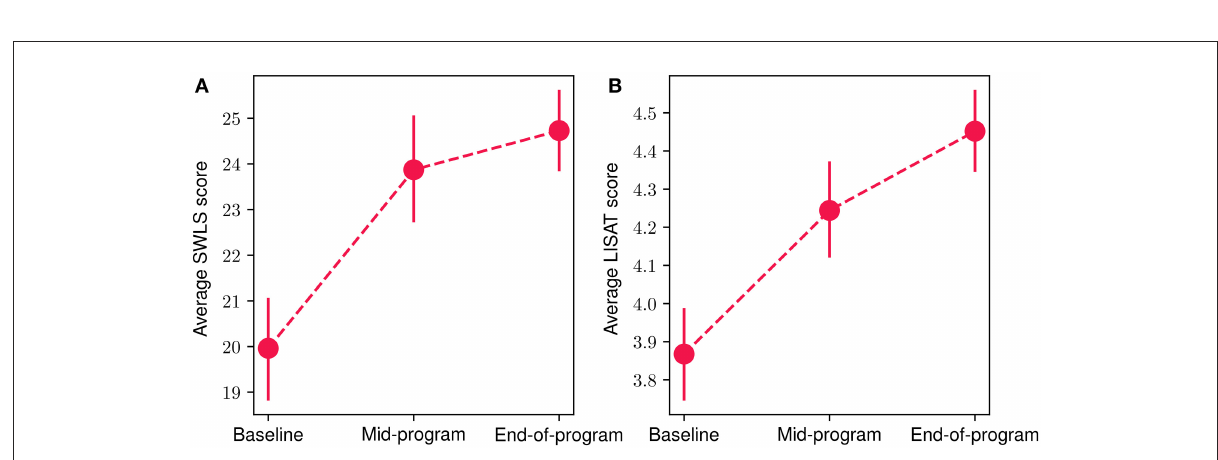
FIGURE8 Mean participant SWLS (A) and LISAT- 11 (B) scores at baseline, mid-program and end-of-program evaluations. The vertical bars represent the standard